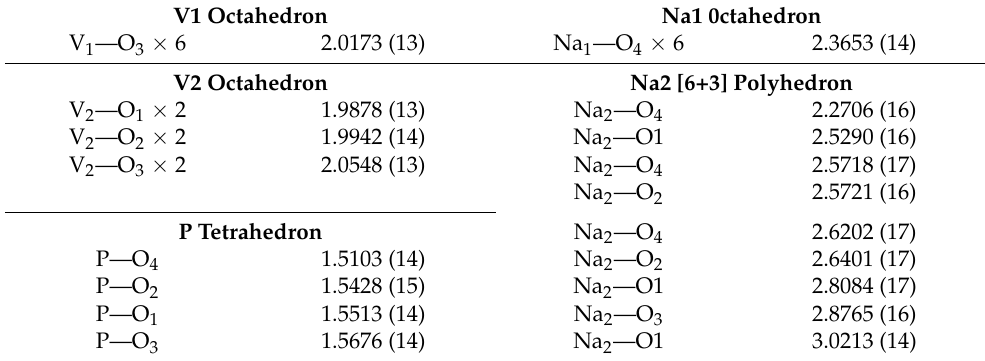
Table 2. Selected distances